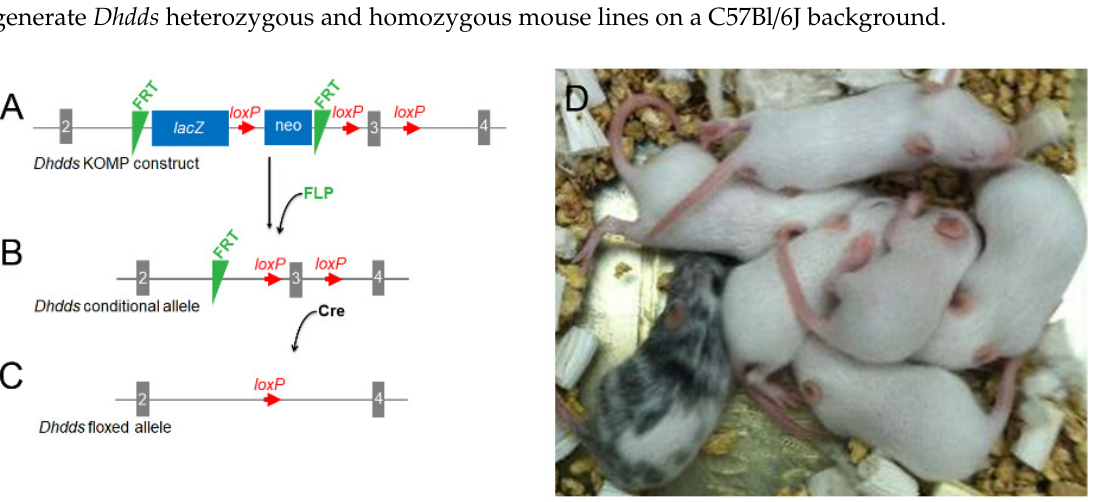
Figure 1. Generation of Cre-dependent Dhdds conditional knockout (KO) mice. ( A ) A validated Dhdds construct from the Knockout Mouse Project (KOMP) (U.C. Davis) was linearized and introduced into mouse ESCs. ( B ) Transformed cells were treated with FLP-FRT recombinase and PCR was used to verify lacZ cassette excision. ( C ) Clones from confirmed FRT-excised alleles were used to generate Dhdds flx / flx- mice. ( D ) Pups carrying the Dhdds floxed allele were identified by coat appearance.